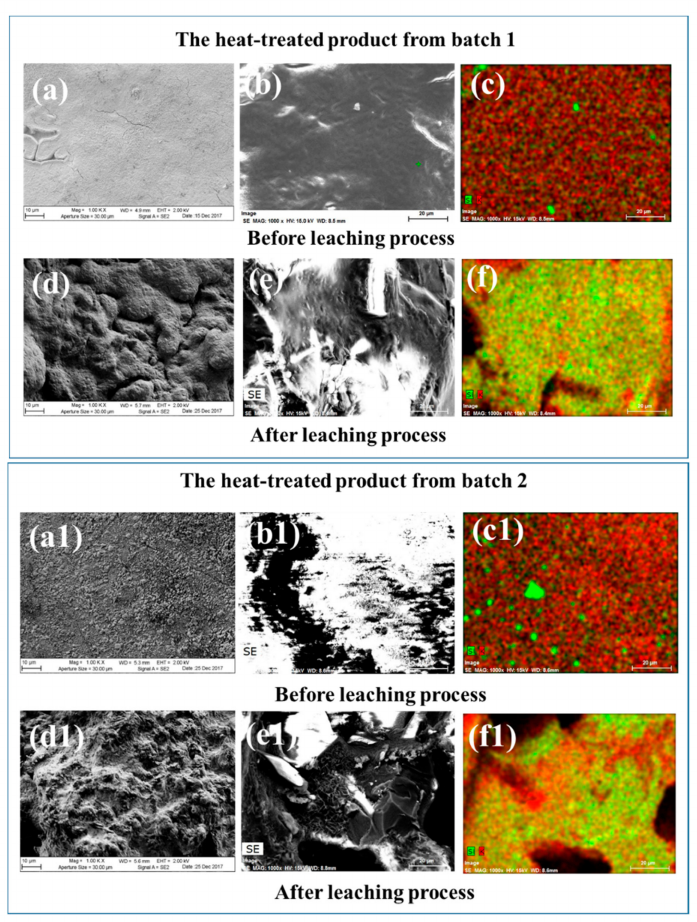
Figure 6. The surface morphology of the heat-treated products obtained from the two batches: FE-SEM images of the glass surface batch 1 and their corresponding mapping images of silicon and potassium elements before ( a – c ) and after ( d – f ) leaching process; FE-SEM images of the glass surface batch 2 and their corresponding mapping images of silicon and potassium elements before ( a1 – c1 ) and after ( d1 – f1 ) leaching